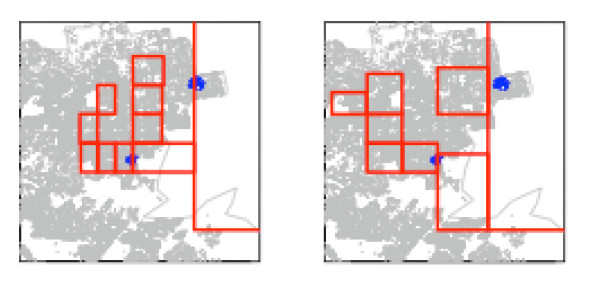
RC B: FleXScan results, including the only qualifying result. The only LACT result that met qualifications was FleXScan for Set 1. From the left, Set 1 and Set 2 (RR = 1.69) are outlined in red. These clusters connect the only point clusters, in blue, that had p values below 0.2 (births < 115). None of the point-identified clusters met acceptance criteria. All other located births are gray points. There is no consensus or potential cluster for RC B.